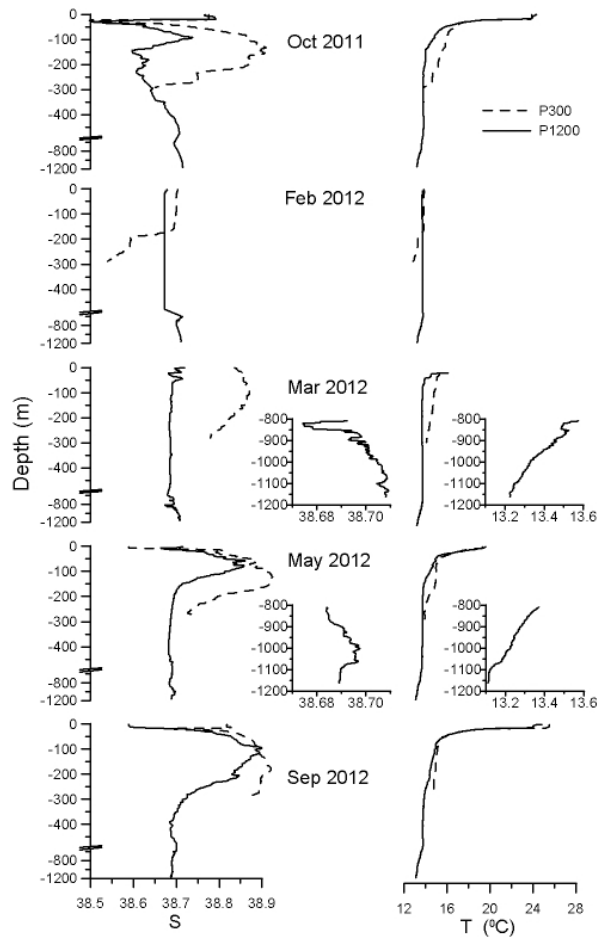
Figure 2. Vertical distribution of salinity ( S ) and temperature ( T